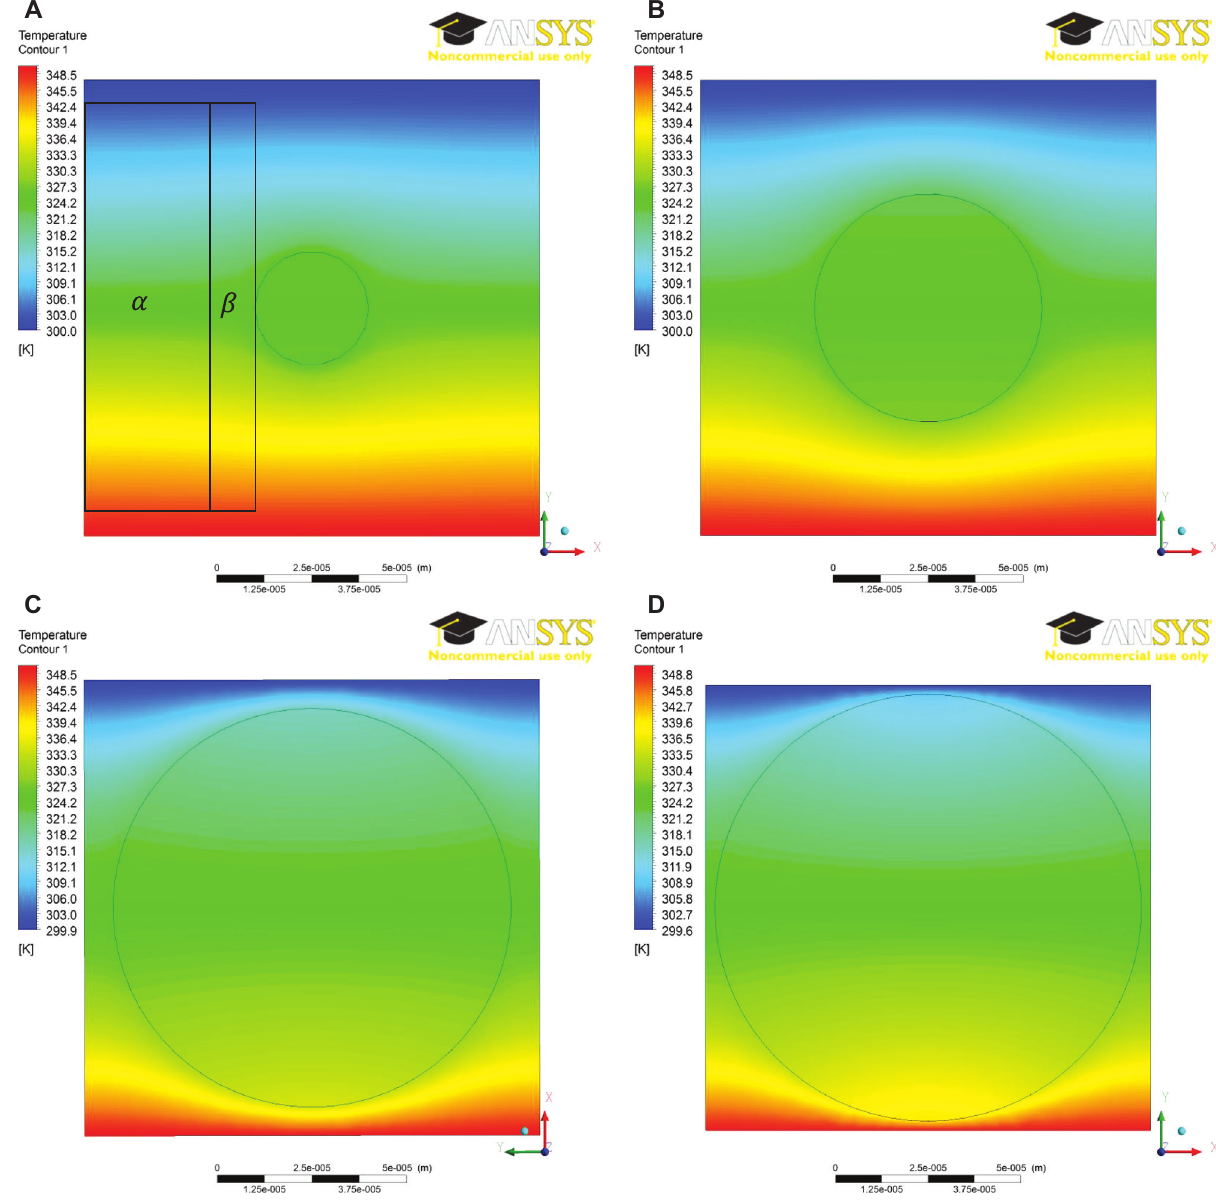
= 0.049, (B) V = 0.196, (C) V = 0.601 and (D) f f f